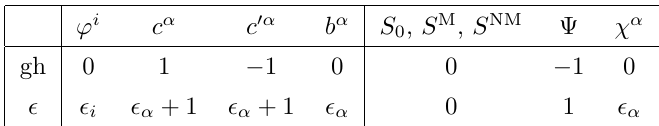
Table 1 . Ghost numbers and Grassmann parities of the various objects appearing in the irreducible case. Antifields have ghost number given by gh(Φ ∗ ) = (cid:15) (Φ I ) + 1 (cid:15) (Φ ∗ I